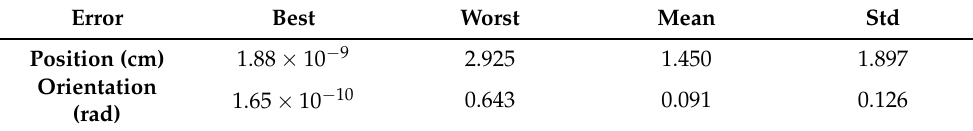
Table 3. Statistical results of MO-M-PSO for IK